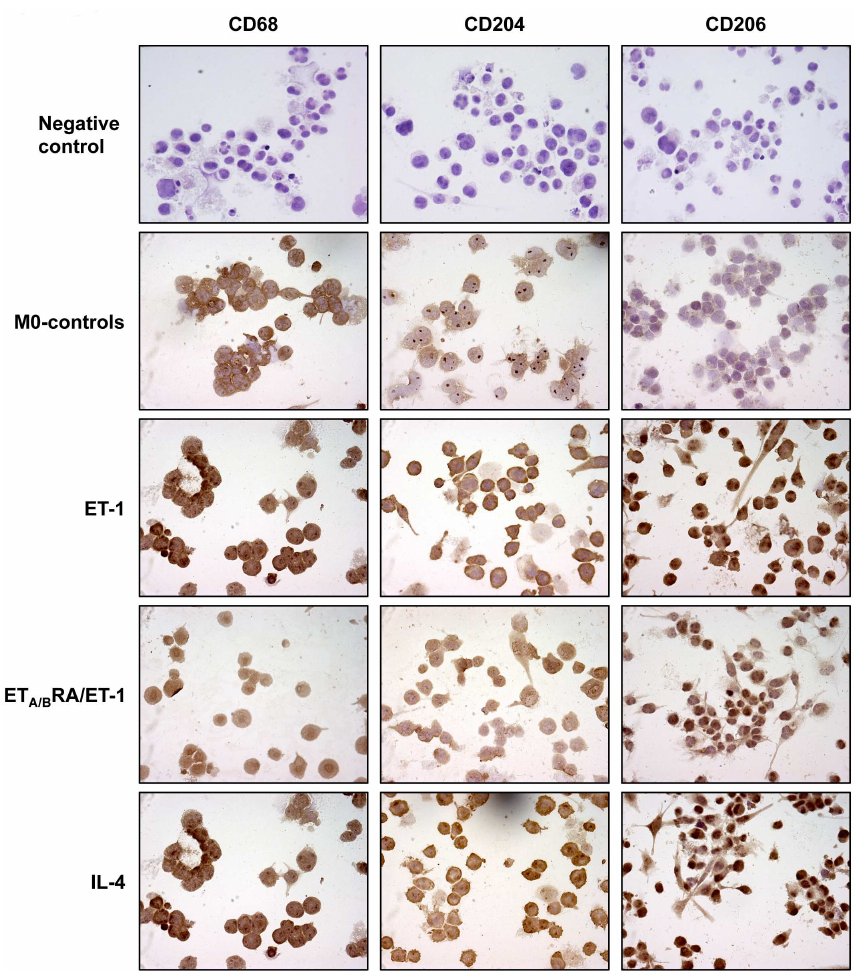
Fig 1. Evaluation of CD68, CD204and CD206 expression in cultured THP-1-derived macrophages. Immunocytochemistry of CD68(marker of macrophage activation), CD204and CD206proteinexpression in culturedTHP-1-derived macrophages (M0 macrophages) treated for 72 hours with ET-1 (100nM)and IL-4 (10ng/mL) alone,or pre-treatedwith ET A/B RA (bosentan,10 -5 M) for 1 hourbefore beingstimulatedwith ET-1. Cultured M0 macrophages maintainedfor 72 hours in RPMI at 5% of FBS were used as controls (M0-controls). Immunocytochemistry was performedon four independent in vitro experiments. The detectionof protein expression was performed evaluating the same numberof cells by light microscopy (magnification